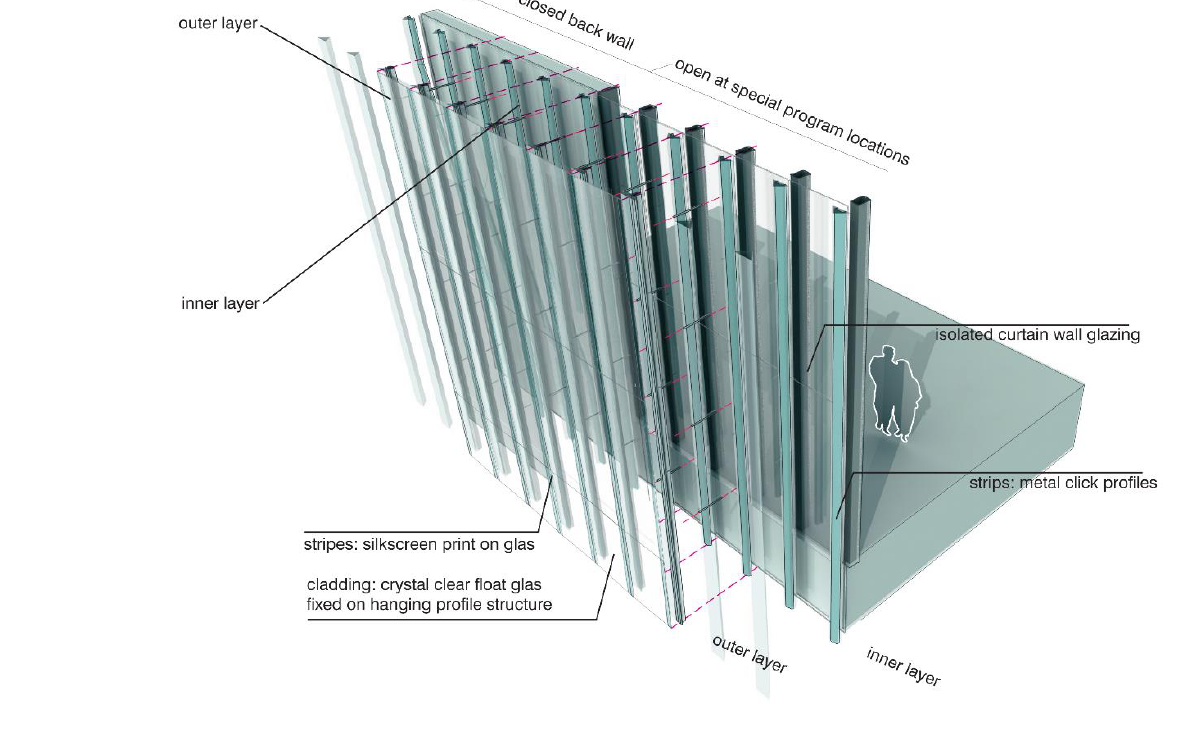
Fig. 5 Façade components of the Galleria Centercity. © UNStudio.